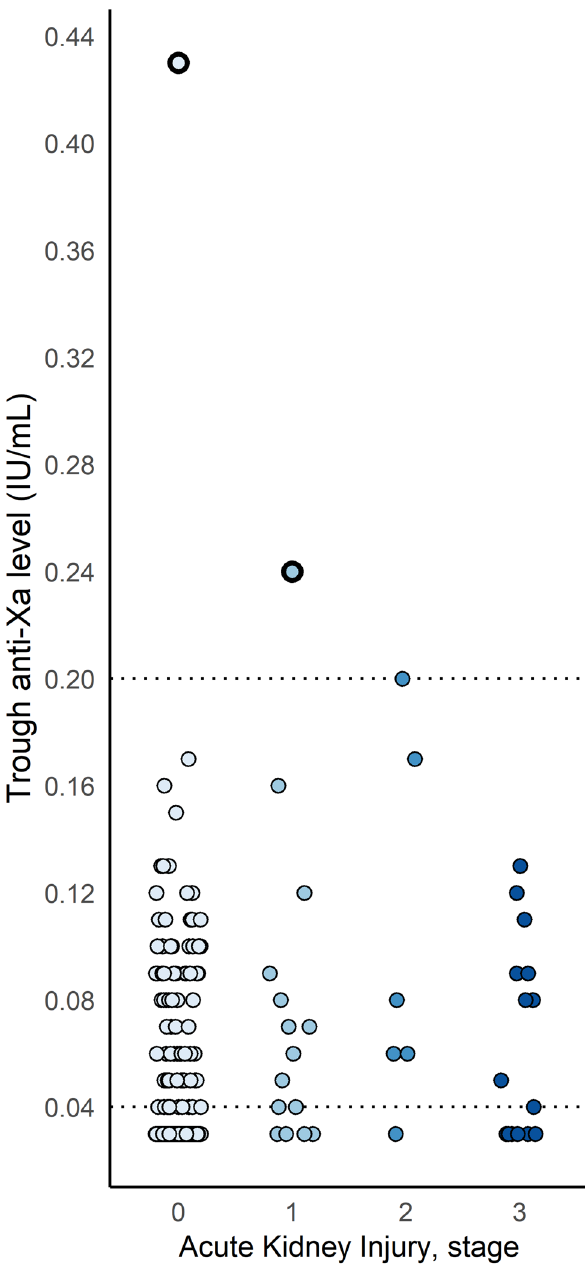
Figure 1. Trough anti-Xa levels according to the presence of AKI (includes clustered data). The horizontal dotted lines indicate the respective cut-off points for the limit of detection (< 0.04) and our definition of bioaccumulation (> 0.20 IU/ml). The plot shows 234 trough anti-Xa levels of 108 patients who received intermediate dose nadroparin. The plot is intended for a general overview of the data and includes clustered data, so no summary statistics are